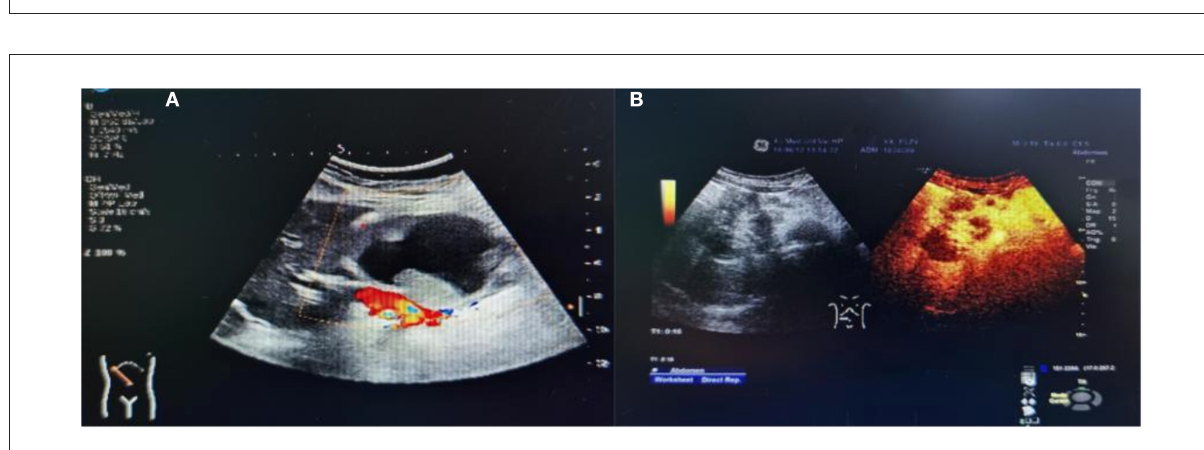
FIGURE2 Ultrasound images of children with SPN. (A) Conventional ultrasound. (B) Contrast ultrasound.